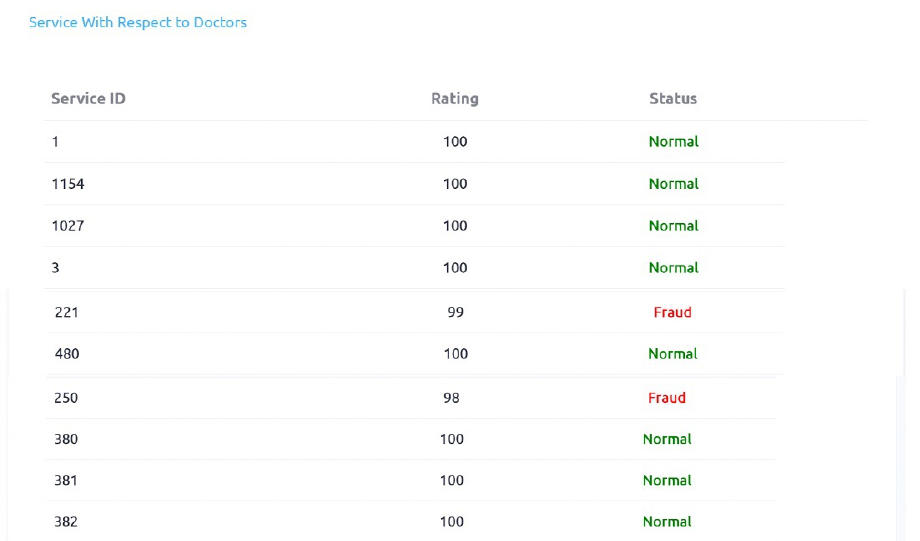
Figure 19. Service wrt Patient Rating and status.